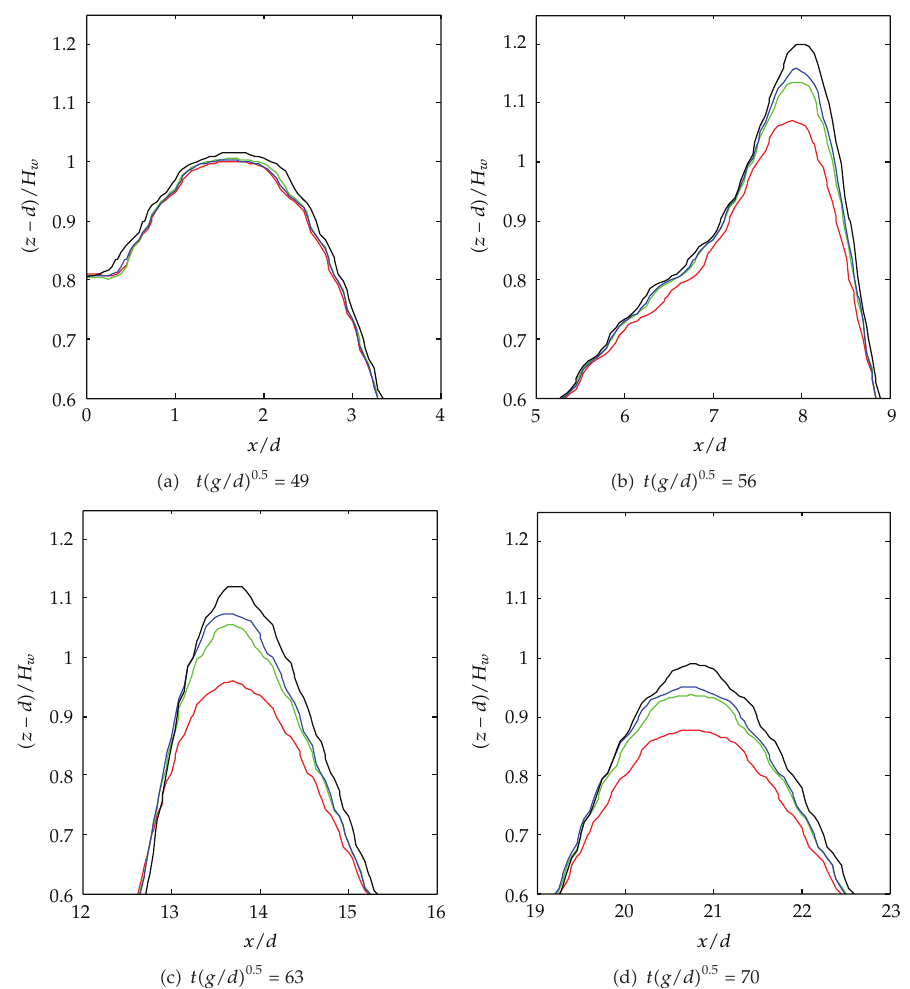
Figure 3: The e ff ect of structural porosity on wave transformation for porosity n (cid:7) 0 black curve, n (cid:7) 0 . 2 blue curve, n (cid:7) 0 . 4 green curve, and n (cid:7) 0 . 6 red